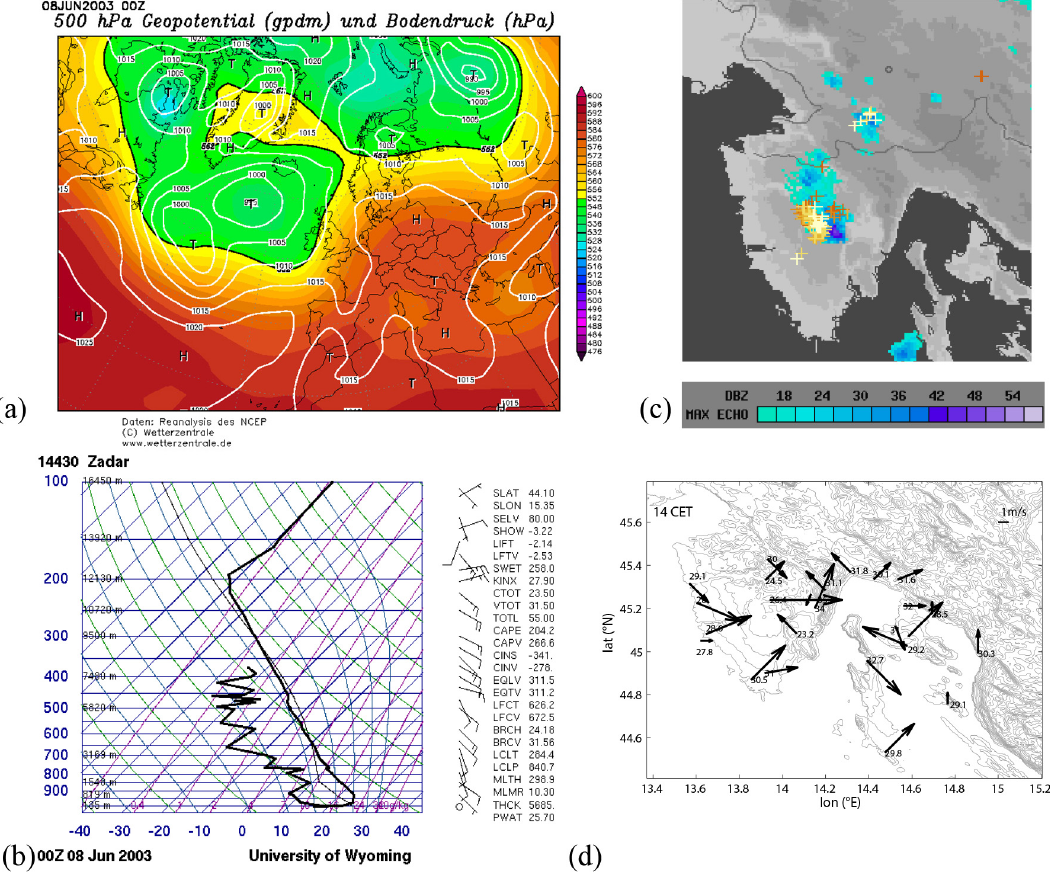
Fig. 9. Case C3, 8 June 2003: (a) surface and 500hPa pressure distribution at 00:00UTC (i.e. 01:00CET); (b) radio sounding profiles plotted on a skew T-log p diagram in combination with convective indices in Zadar (44.10 ◦ N, 15.35 ◦ E) station at 00:00UTC (i.e. 01:00CET); (c) cloud-to-ground lightning distribution (crosses), from 13:00 to 14:00CET and radar echo (blue areas); source: ARSO – www.meteo. si (Slovenian Environment Agency). The coloured crosses indicate the detection of lightning: yellow (<10min) – orange (>50min); (d) measured 10m wind vectors (ms − 1 ) and 2m air temperatures ( ◦ C) at 14:00CET (measuring sites in Fig.